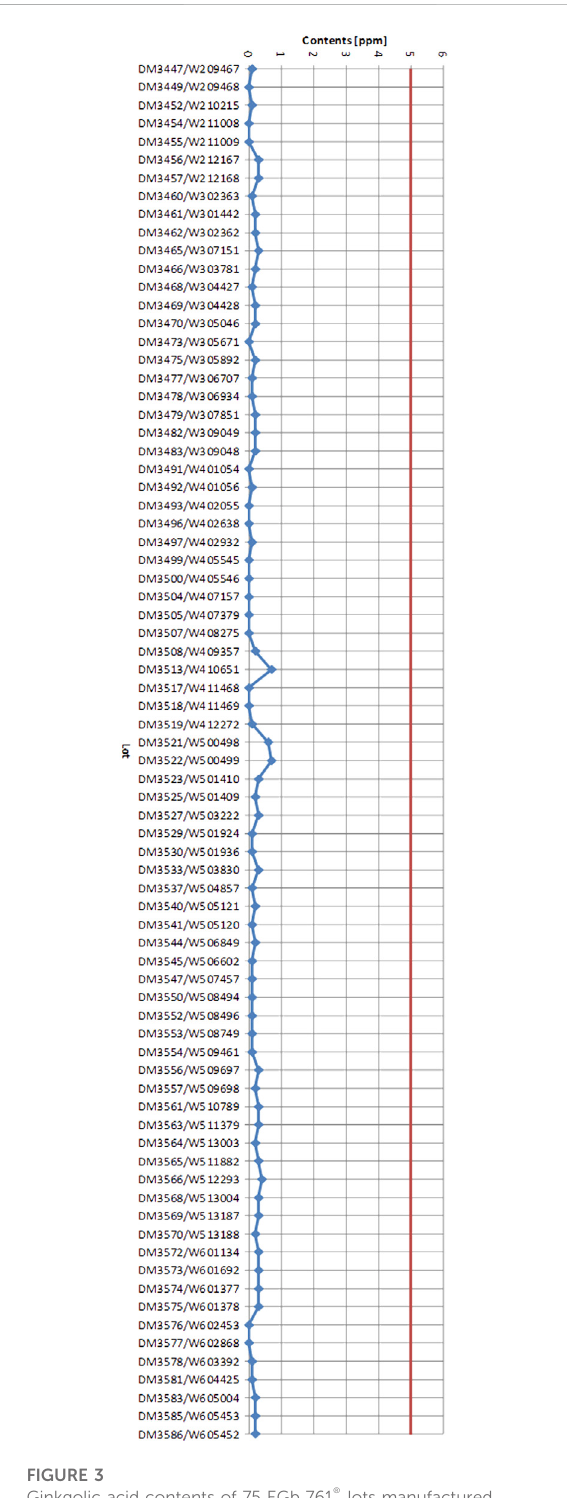
FIGURE 3 Ginkgolic acid contents of 75 EGb 761 ® lots manufactured consecutively. The red line marks the maximum Ginkgolic acid concentration of 5 ppm allowed according to European